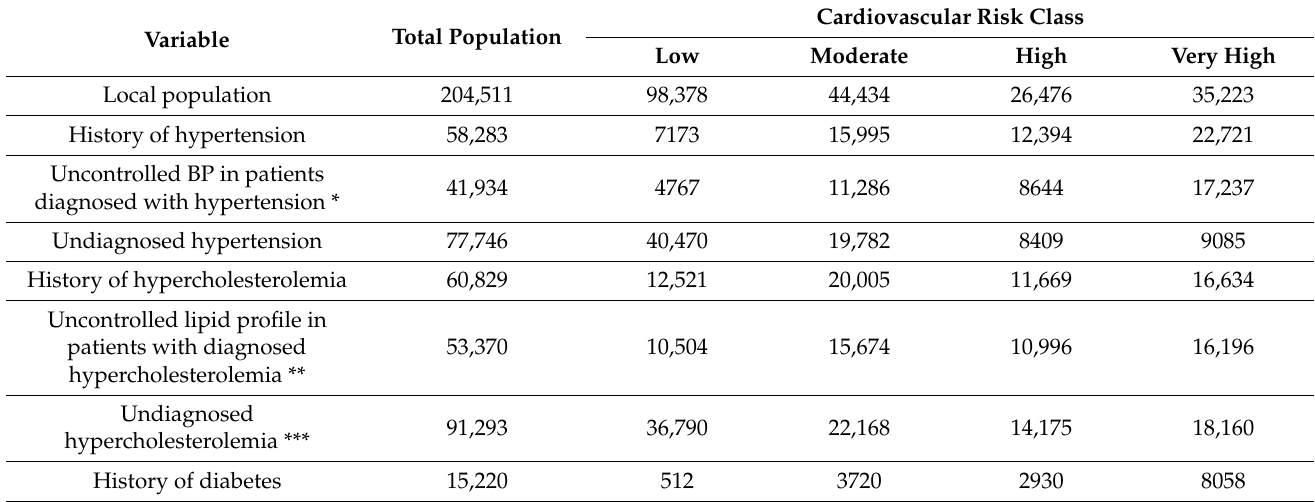
Table 6. Estimated cardiovascular disease burden in the local